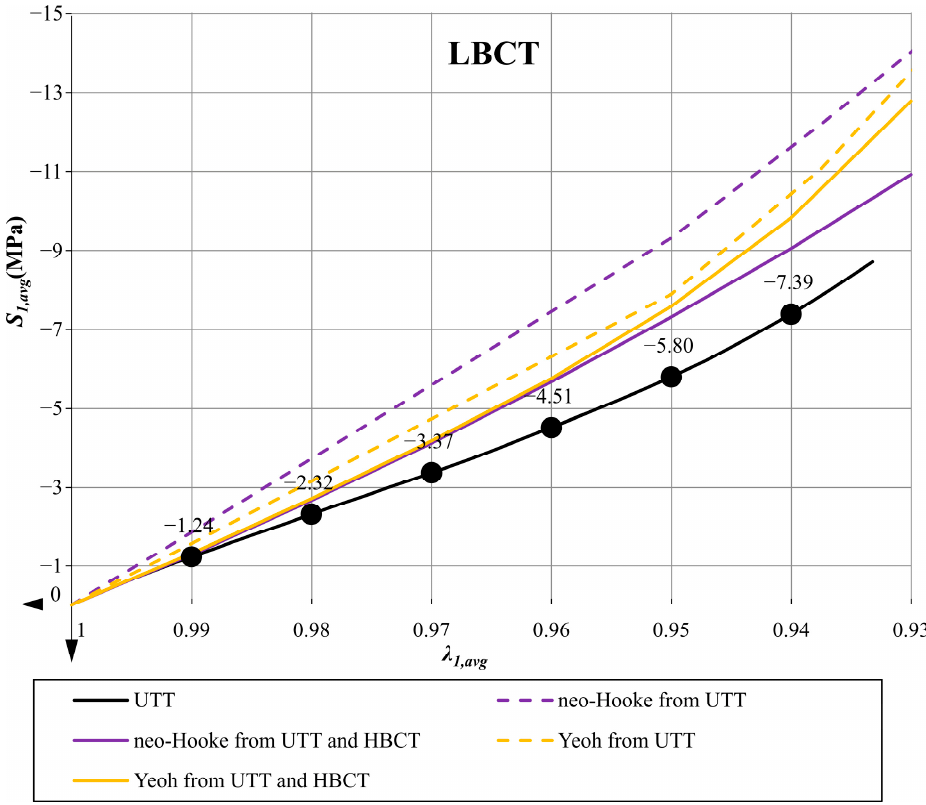
Figure 11. Comparative plot of the average pressure stress S 1,avg as a function of the average elongation λ 1,avg in case of LBCT.